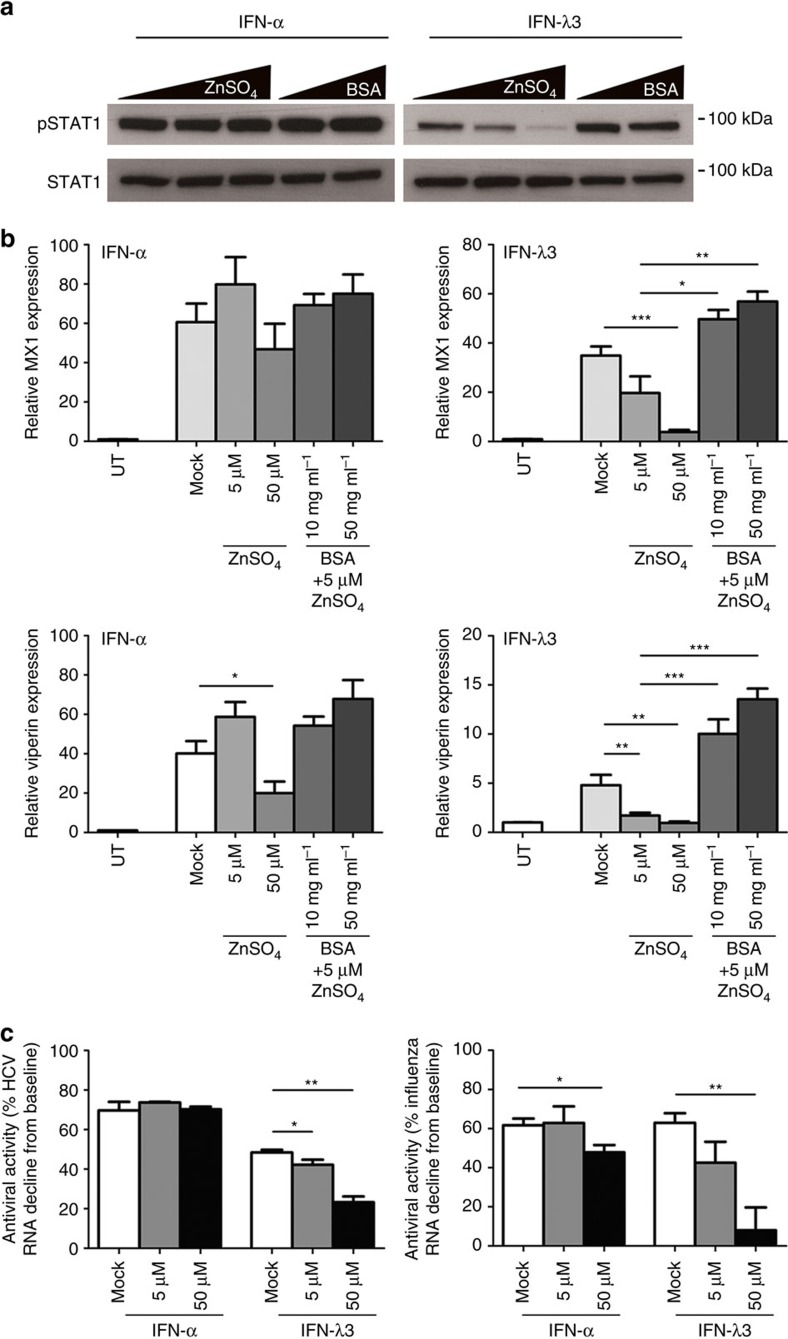
Zinc potently inhibits the IFN-λ3 response.(a) Huh-7 cells were treated with 50 U ml−1 IFN-α or 100 ng ml−1 IFN-λ3 in combination with increasing amounts of zinc (0, 5 and 50 μM ZnSO4) or 5 μM ZnSO4 in combination with 10 mg ml−1 or 50 mg ml−1 BSA to sequester zinc. STAT1 phosphorylation 30 min post IFN-λ3 treatment was dose-dependently inhibited by ZnSO4, and reversed with albumin. IFN-α treatment however, was unaffected. (b) The expression of IFN-λ3-induced ISGs, MX1 and viperin, were affected in a similar manner, with minimal effects on IFN-α-mediated ISG expression (Welch's t-test). (c) To determine if zinc inhibits the antiviral response, Huh-7 cells infected with the JFH-1 strain of HCV and H1N1 influenza virus were treated with IFN-α and IFN-λ3 in combination with zinc. IFN-α-reduced JFH-1 intracellular RNA by ∼75% independent of zinc concentration, however the antiviral activity of IFN-λ3 was significantly reduced from ∼50% to ∼20% with 50 μM ZnSO4. The antiviral activity of IFN-α against influenza virus was only partially inhibited by zinc, however a similar dose-dependent inhibition of IFN-λ3 antiviral activity was observed, almost ablating its effects at 50 μM ZnSO4 (Welch's t-test). Data are representative of two (western blotting) and three (gene expression) independent experiments. *P<0.05, **P<0.01, ***P<0.001, (mean±s.e.). UT, untreated.